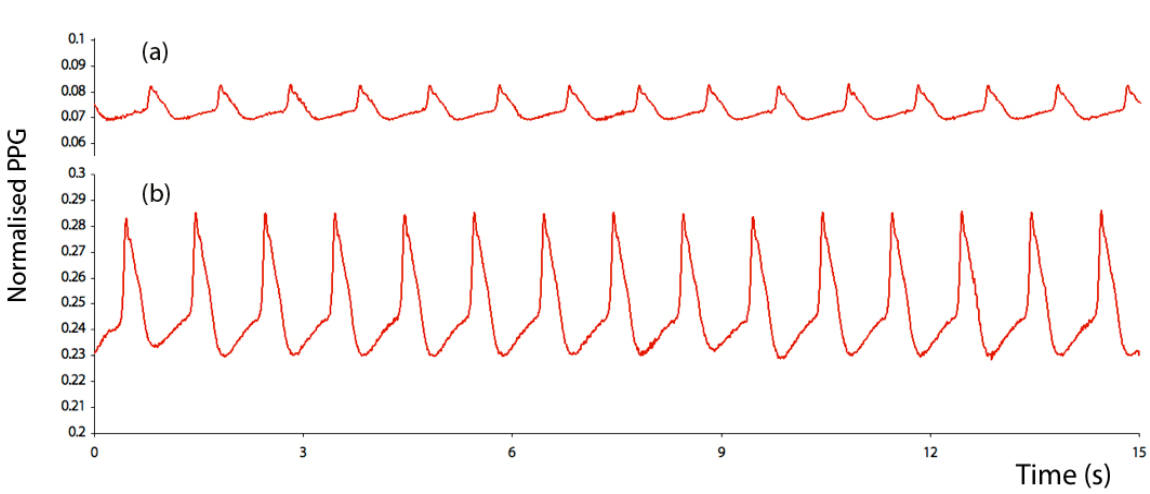
Figure 5. Samples of the time-varying photoplethysmograph (PPG) signal obtained when the systolic pressure was 250 mmHg and the dye concentration was equivalent to a hemoglobin concentration of ( a ) 5 g/dL, and ( b ) 20 g/dL.